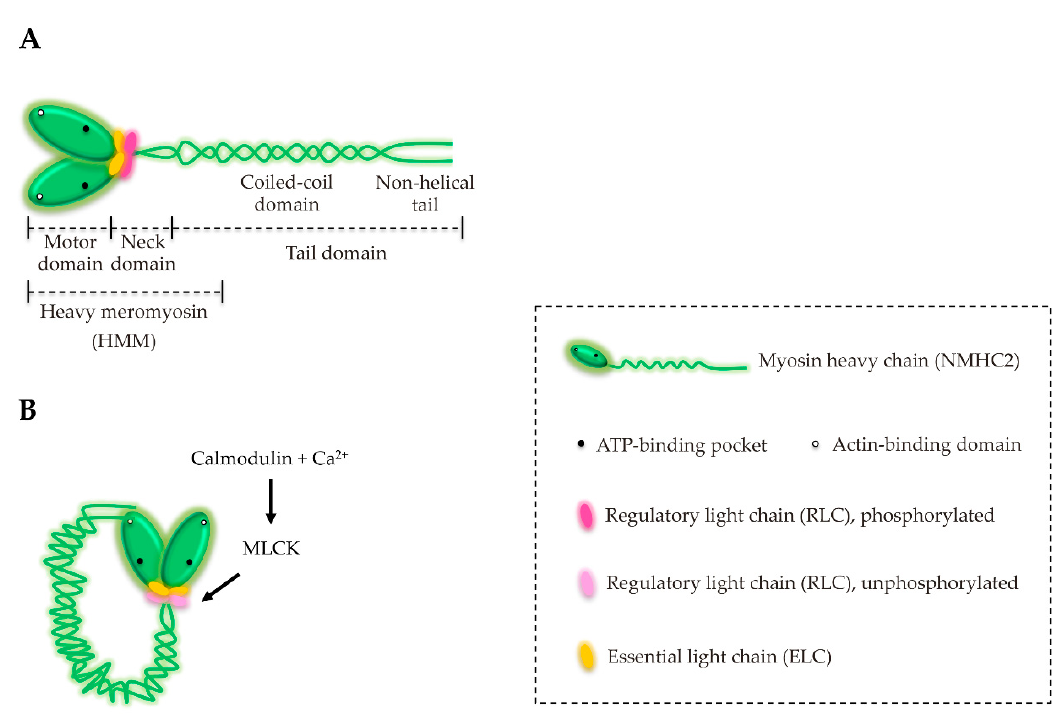
Figure 2. The structure of non-muscle myosin 2 (NM2). ( A ) NM2 is a hexamer composed by two heavy chains (green) and four light chains: Two regulatory (RLC, pink) and two essential light chains (ELC, yellow). The full NM2 complex can be structurally divided in three regions: The motor, the neck and the tail domains. The head domain includes the ATP- and actin-binding sites. The light chains associate with the heavy chains in the neck domain. The heavy meromyosin (HMM) is an NM2 fragment obtained by tryptic digestion and commonly used in in vitro biochemical assays. Even lacking part of the tail, HMM maintains the structure and the biochemical properties of the full molecule. ( B ) Schematic representation of the inactive NM2 molecule. Unphosphorylated RLC (light pink) promotes the intramolecular interaction between the tail and the motor domain. The phosphorylation of RLC Serine 19 by Myosin light chain kinase (MLCK) turns on NM2, promoting the assembly of filaments and increasing ATPase